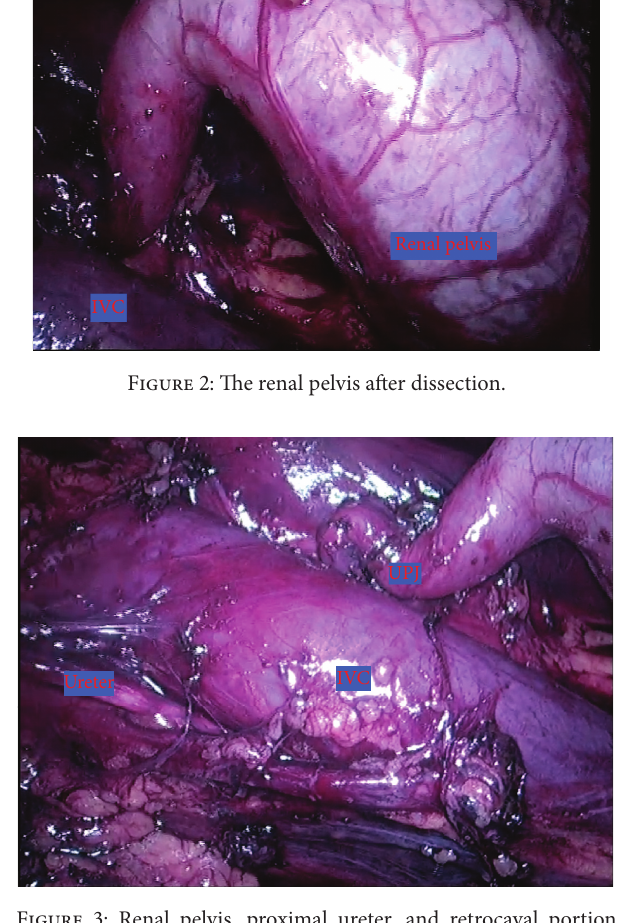
Figure 3: Renal pelvis, proximal ureter, and retrocaval portion dissected and mobilized.